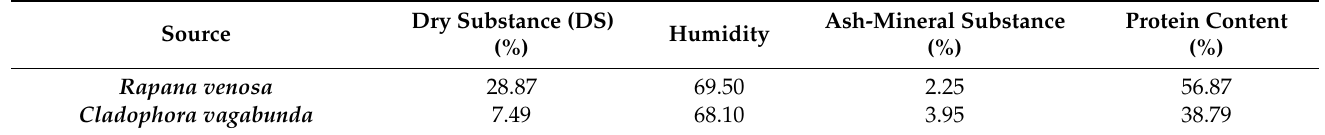
Table 2. Biochemical parameters of marine sources (correlated to the dry substance, DS